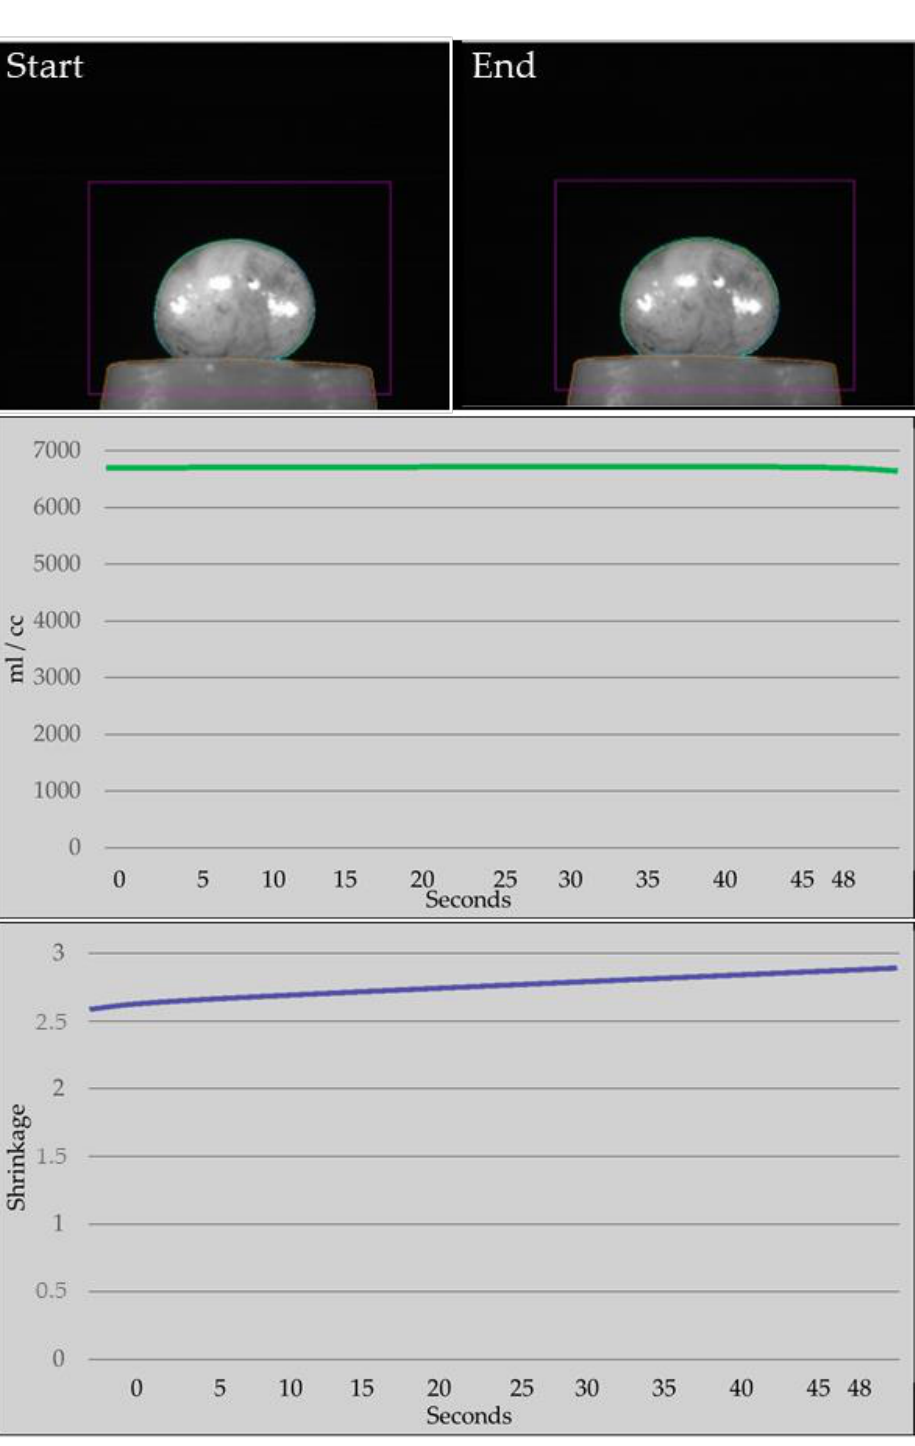
Table 2. Mean and standard deviation for the volumetric shrinkage according to the factor resin composite materials. Same Capital Letter(s) means no statistical difference among groups (α = 0.05). Material Mean ± Stand. Dev.